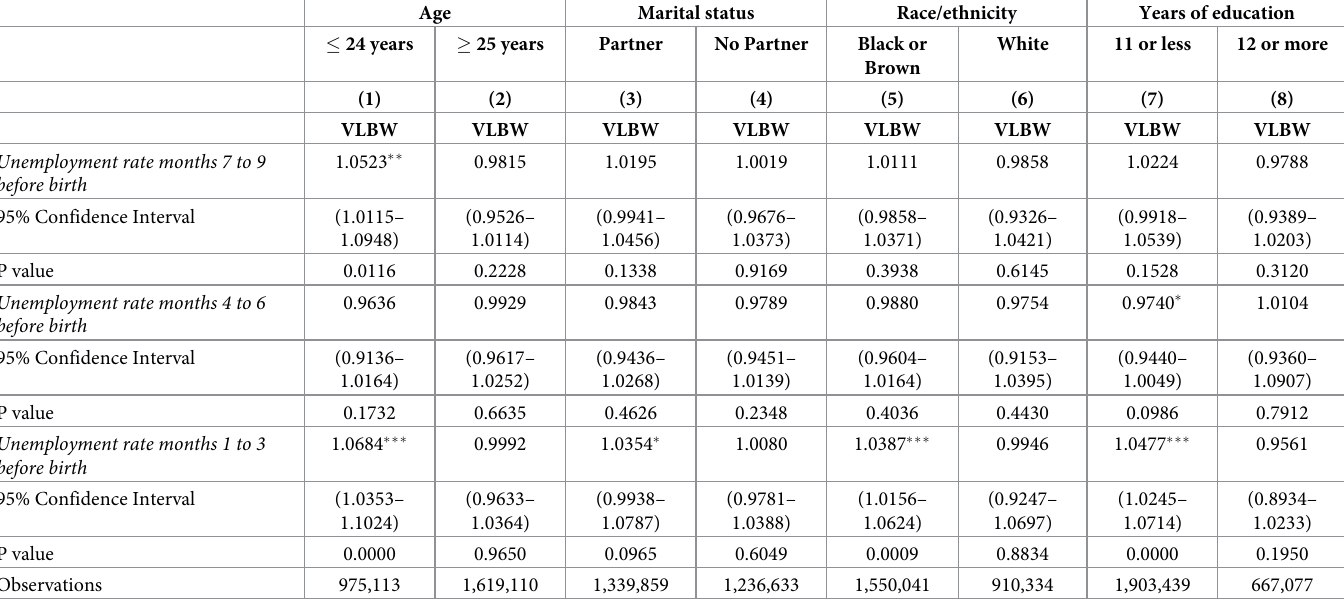
Table 4. Unemployment rate at the mother city of residence and